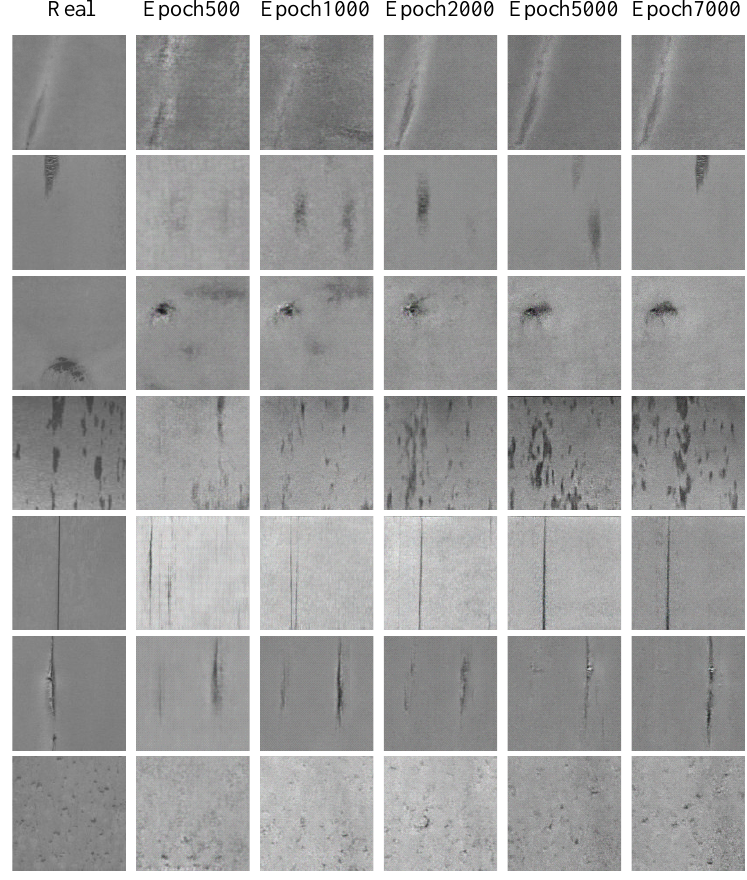
Figure 7. Strip steel surface defect image samples generated by WGAN in different